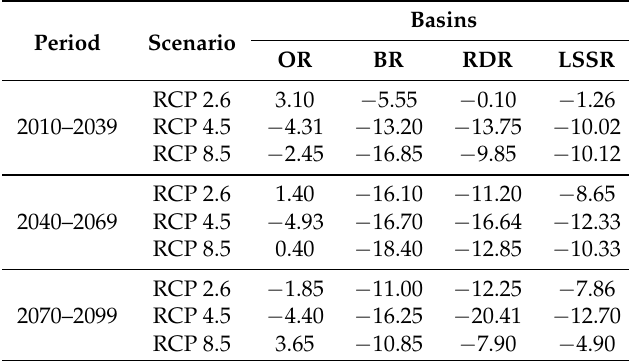
Table 2. Percentage changes in the mean annual maximum flow for different scenarios with respect to the 1975–2009 base period of the SSR